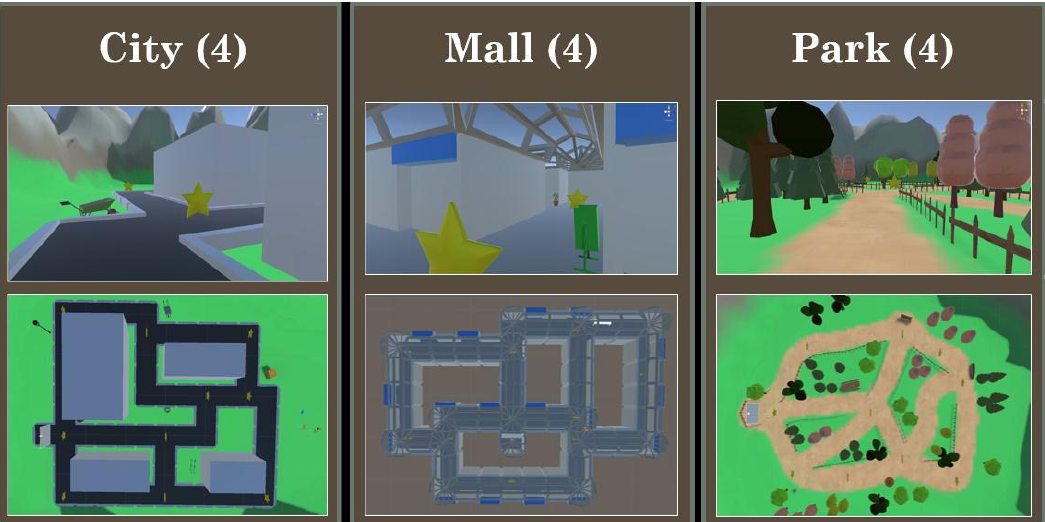
Figure 1. First-person view and bird’s-eye view of the three virtual environment styles. For each style, we created 4 exemplars, though only one from each is shown here. The Stars are visible in the environments during encoding, but not during retrieval. Participants only experienced the environments from a first-person